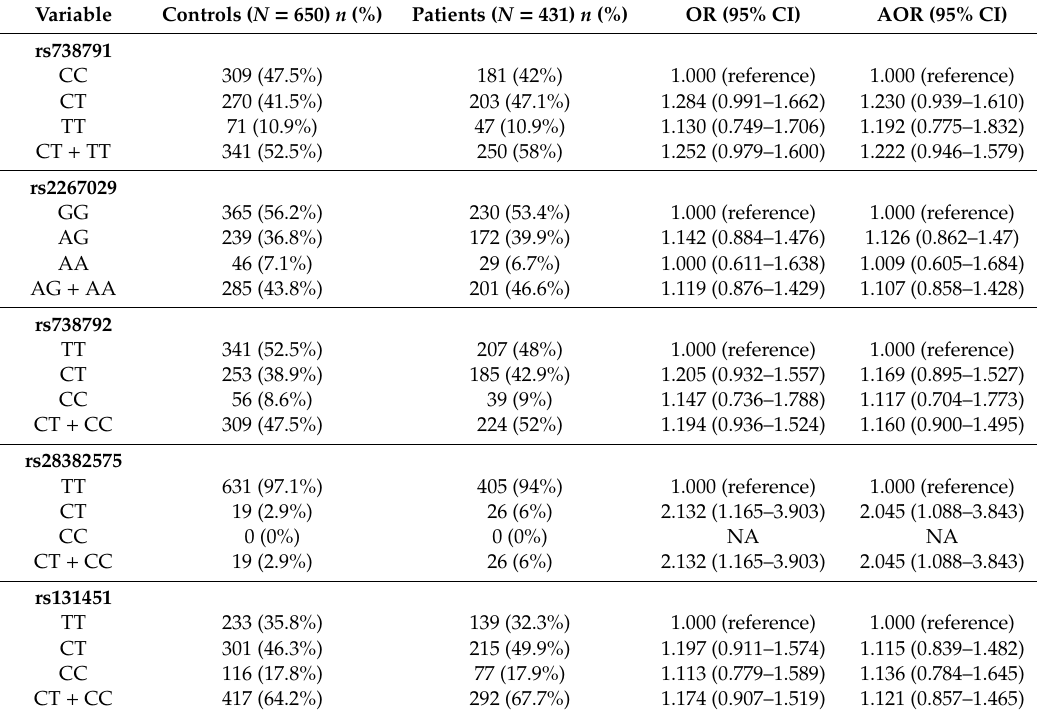
Table 2. Genotype Distributions of MMP11 Gene Polymorphisms in 650 Controls and 431 Patients with